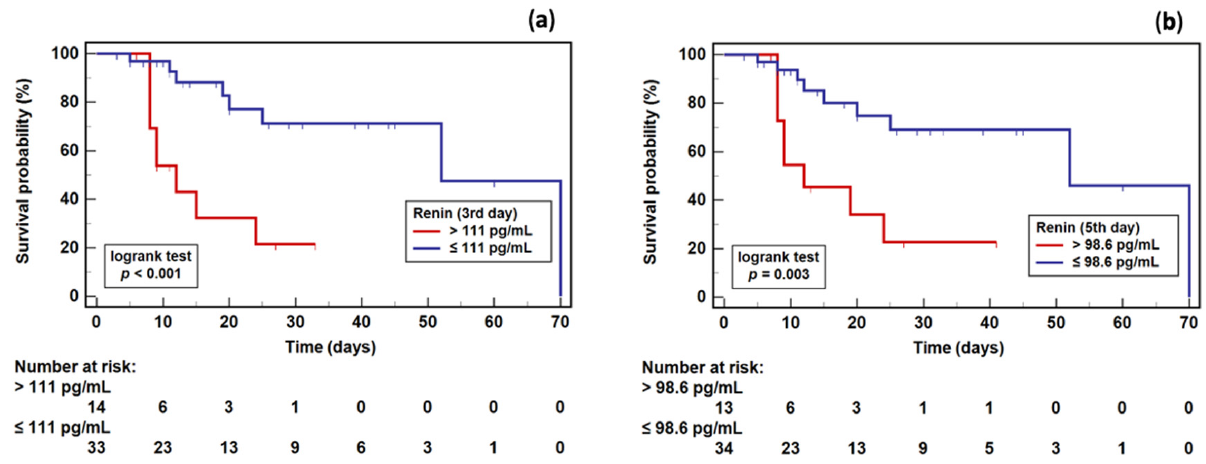
Figure 7. Renin as a 28-day survival marker (blue line): ( a ) determined on the third study day; ( b ) determined on the fifth study day. Legend: Dotted lines—95% CI. Notes: Data were analyzed using receiver operating characteristics (ROC) curve analysis. AUC, area under ROC curve, interpreted as marker’s overall accuracy; J, Youden index.